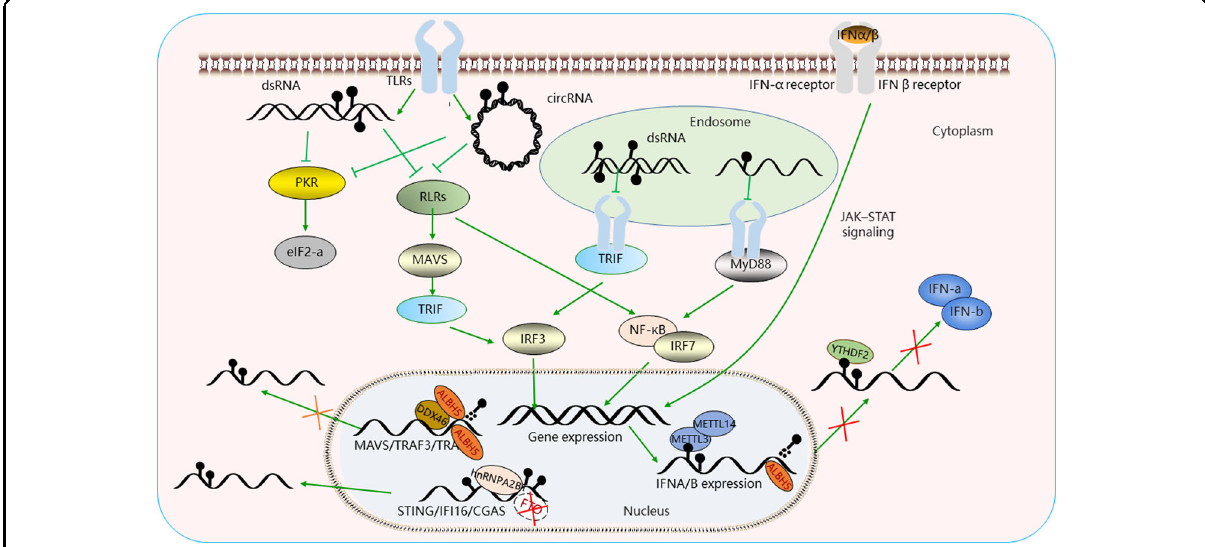
Fig. 2 The m6A alters innate immunity evasion. Pathways that are activated by viral RNAs in mammalian cells that express the RLRs, TLRs, PKR, and m6A regulates the process of infection through diverse mechanisms, which increase the risk of immune